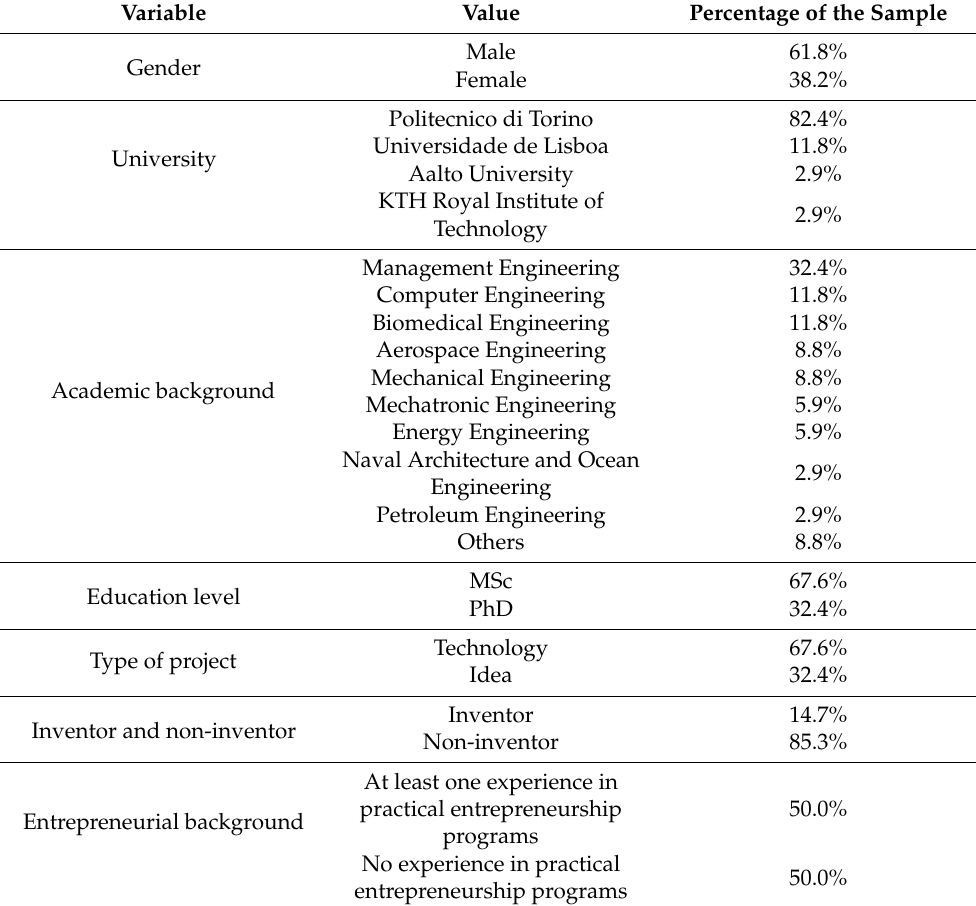
Table 2. Distribution of students by the following variables: gender, university, education level, type of project, inventor and non-inventor and entrepreneurial